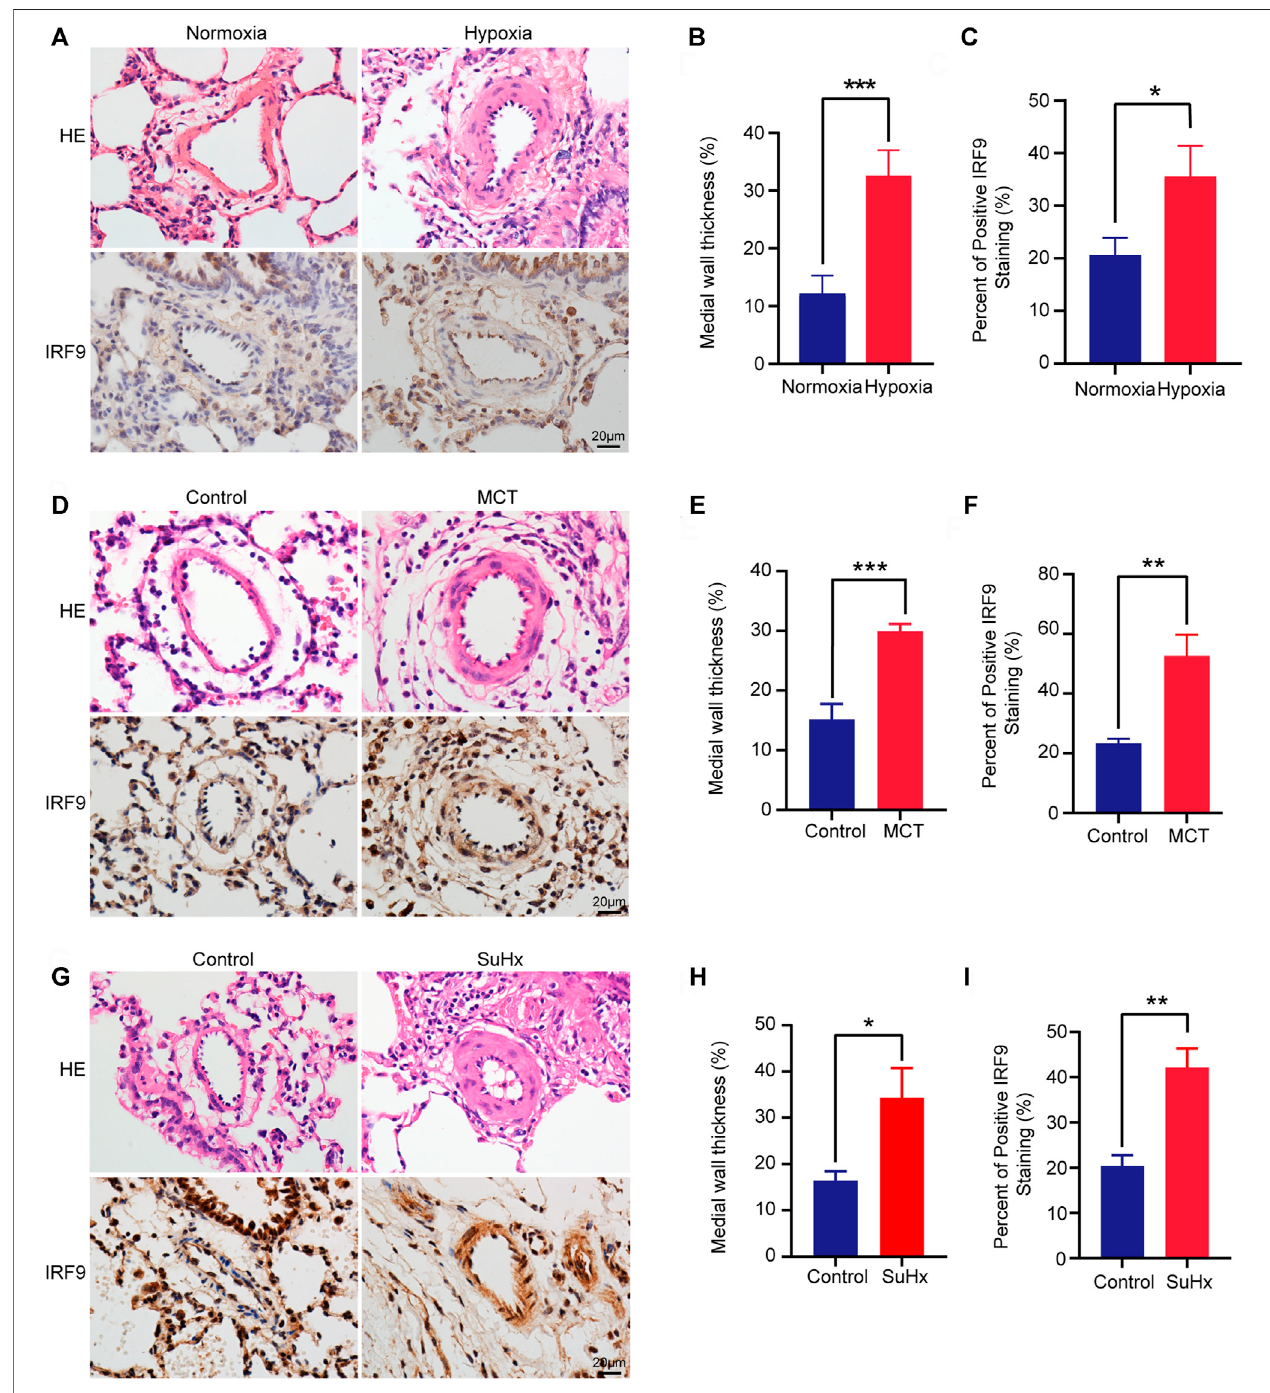
FIGURE 1 | IRF9 expression is upregulated in the thickened medial wall of the pulmonary artery in chronic hypoxia, MCT and SuHx rat PAH models. (A) The representative pulmonary arteriole with Haematoxylin and eosin (HE) staining (the upper panel) and immunohistochemical staining of IRF9 (the lower panel) in the lung sections ofcontrol group and chronic hypoxia-induced rat PAH model. Scale bar (cid:2) 20 μ m. (B) The statistics ofmedial wall thicknesses [innerdiameter/(inner diameter + outside diameter)] of pulmonary arteriole in (A) ( n (cid:2) 3 rats per group). (C) According to the results of immunohistochemical staining, the intensity of medial IRF9 staining was quanti fi ed relative to the area of the medial layer ( n (cid:2) 3 rats per group). (D – F) The representative images of pulmonary arteriole with HE and IRF9 staining in MCT-induced rat PAH model (D) , quanti fi cation of medial wall thicknesses (E) and IRF9 expression level (F) (Scale bar (cid:2) 20 μ m, n (cid:2) 3 rats per group). (G – H) In control and SuHx-induced rat PAH model, HE staining was used to show the remodeling of the pulmonary arterioles (G) , and the degree of thickening is quanti fi ed in (H) ; the expressionofIRF9inthepulmonaryarterioleswasdetectedbyimmunohistochemicalstaining (G) andwasquanti fi ed (I) Scalebar (cid:2) 20 μ m.( n (cid:2) 3ratspergroup).Values are means ± SD; *** p < 0.001, ** p < 0.01, * p < 0.05.